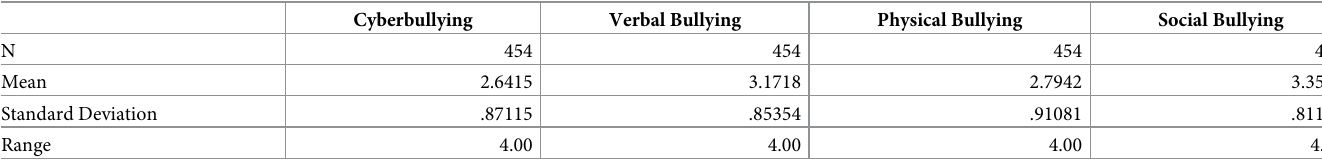
Table 3. Prevalence of different bullying types as perceived by teachers.